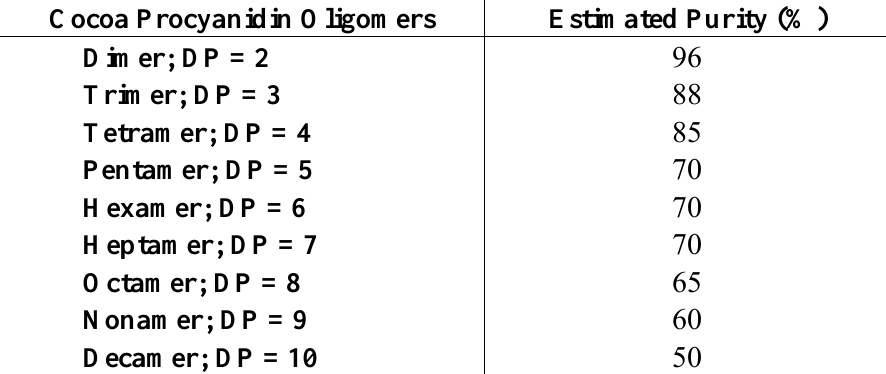
Table 2. Estimation of the purity of each of the isolated cocoa procyanidin preparations.